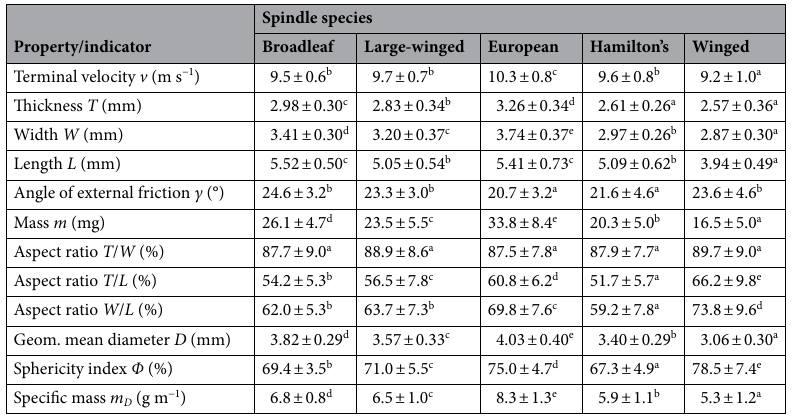
Table 1. Mean values ± standard deviation of the distribution of the physical properties of spindle seeds, with an indication of significant differences. a, b, c—superscript letters denote significant differences between the examined